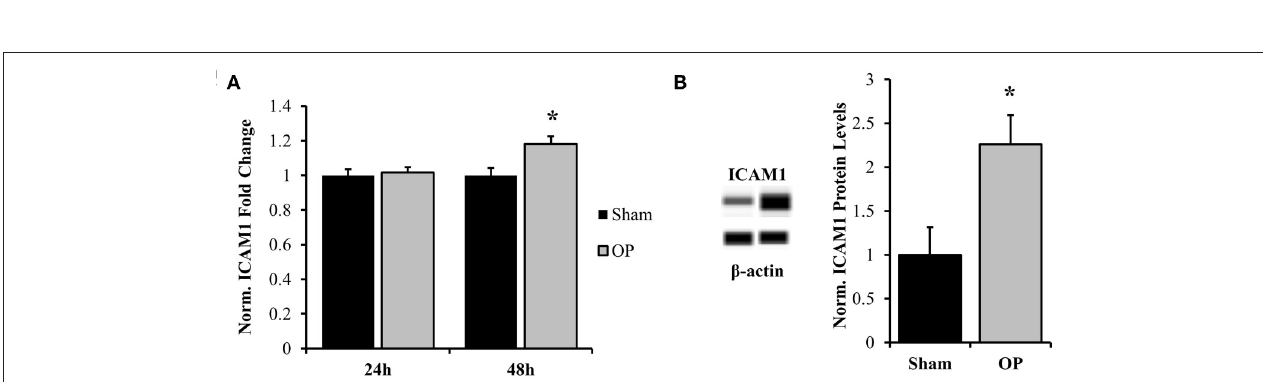
FIGURE 8 | Normalized gene and protein expression of ICAM-1. (A) qPCR results indicated no change in mRNA expression of ICAM-1 at 24h post-overpressure but a significant increase at 48h as compared to sham. (B) Subsequent Western blot results confirmed elevated ICAM-1 protein levels at 48h compared to sham. * p < 0.05, Data are represented as mean ± SEM, gene: n = 7–9/group, protein: n = 8–9/group.